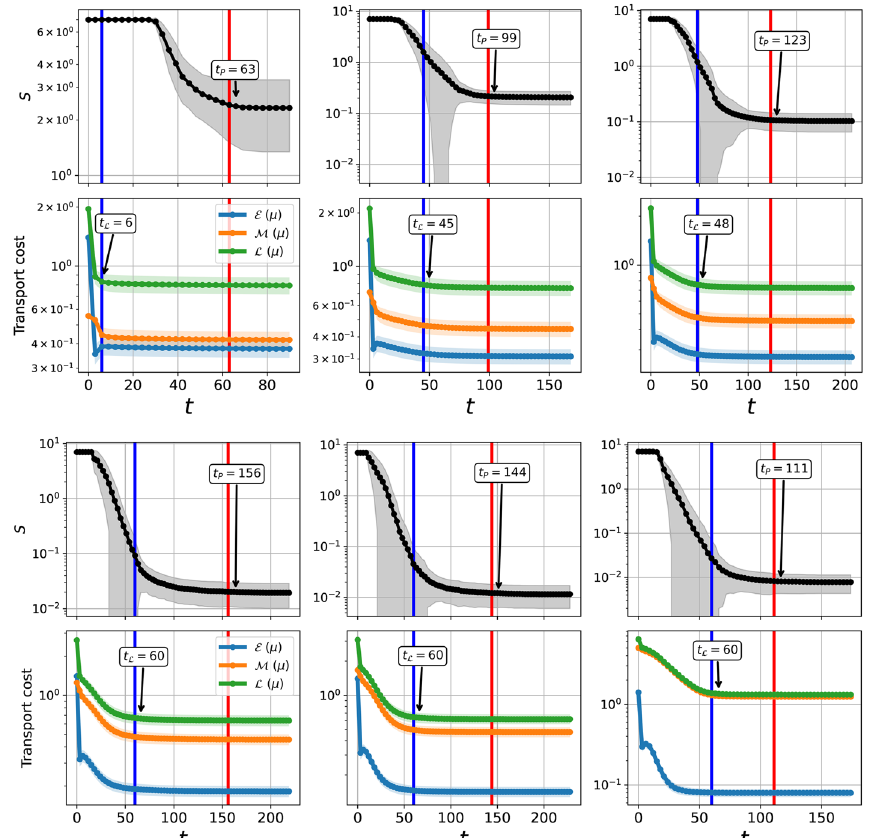
Fig. 8 S and Lyapunov cost. First and second top-down rows: from left to right we see β = 1.1,1.3 and 1.4. Third and fourth top-down rows: from left to right we see β = 1.6,1.7 and 1.9. First and third top-down rows: mean and standard deviation of S as a function of time t ; Second and fourth top-down rows: Mean and standard deviation of the Lyapunov cost L , energy dissipation E and structural cost M of transport densities. Red and blue lines denote t P and t L for p =